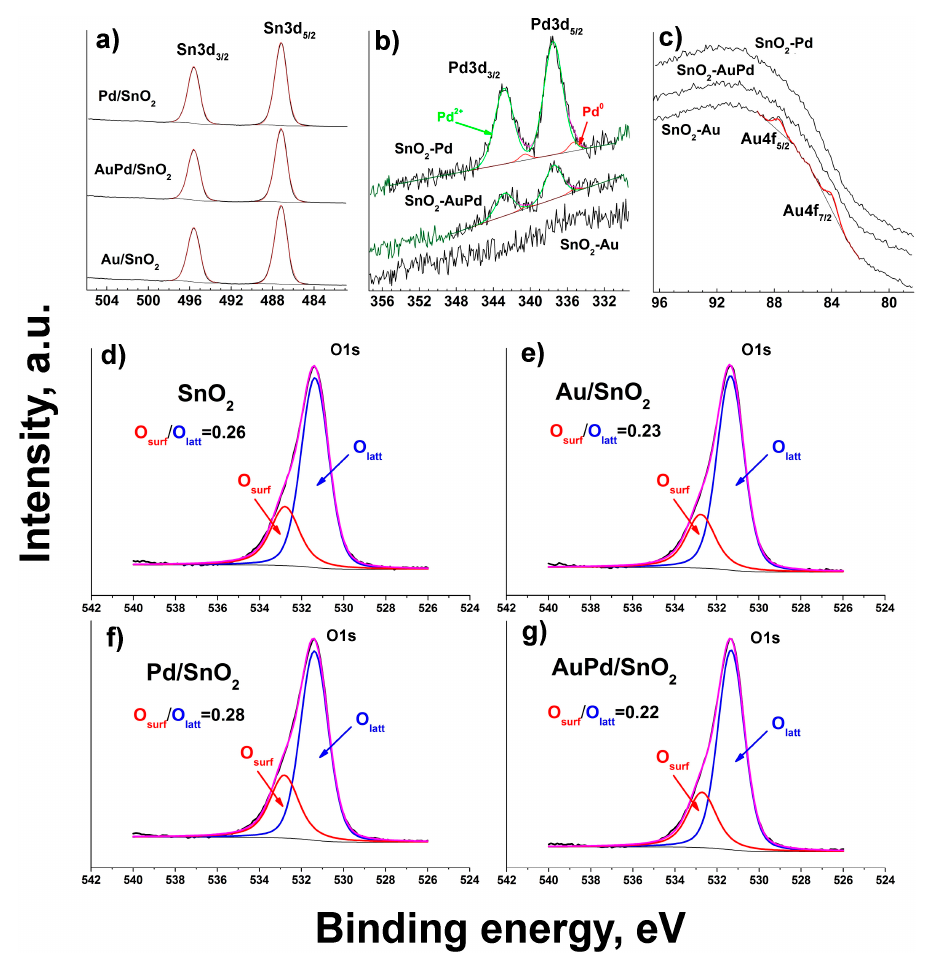
Figure 1. ( a ) Sn3d high resolution XP spectra of metal-loaded materials, ( b ) Pd3d lines and ( c ) Au4f lines for the same samples, ( d – g ) O1s peaks for all synthesized materials.